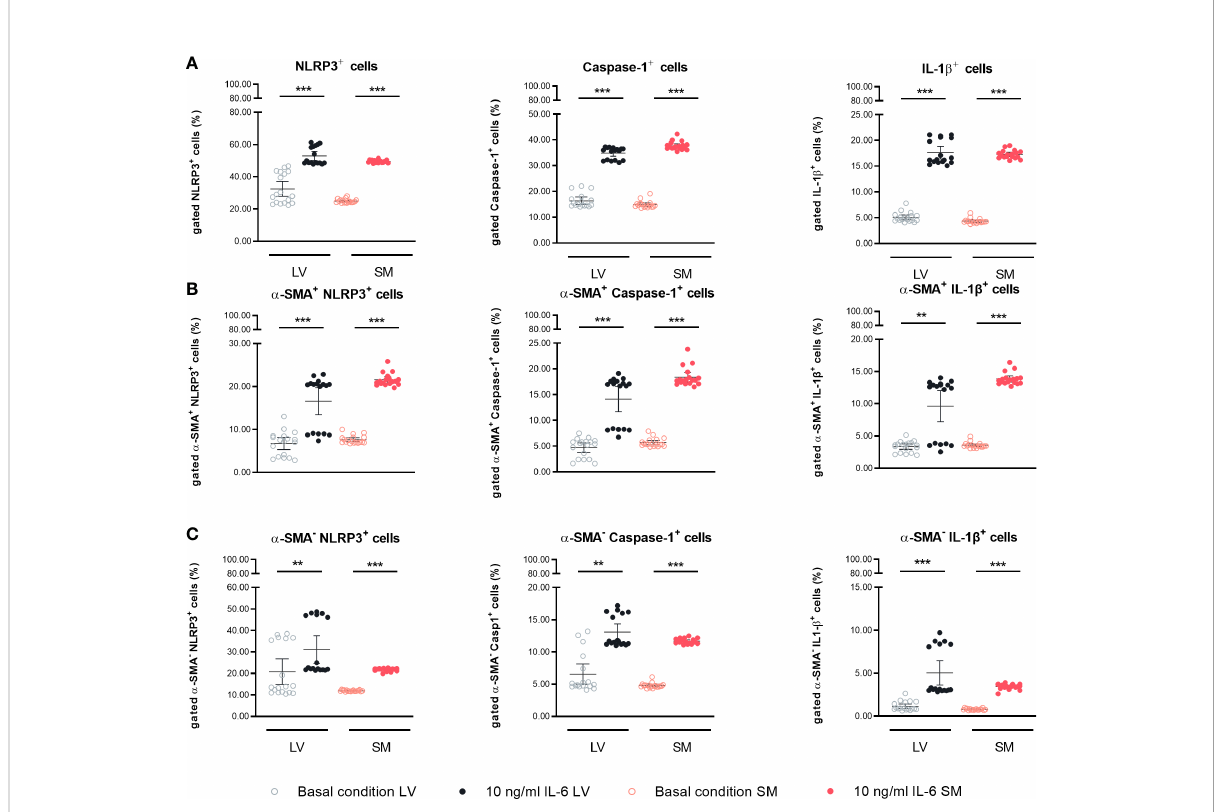
FIGURE 5 IL-6 stimulation leads to upregulation of NLRP3 in fl ammasome activity in left ventricle (LV)- and skeletal muscle (SM)-derived fi broblasts. Percentage of gated (A) NLRP3 + , Caspase-1 + , and IL-1 b + cells in the global population; (B) NLRP3 + , Caspase-1 + , and IL-1 b + cells in the a -SMA + subpopulation; and (C) NLRP3 + , Caspase-1 + , and IL-1 b + cells in the a -SMA − subpopulation of LV-derived (black) and SM-derived (red) fi broblasts after 24-h culture with basal medium without IL-6 (basal condition; bright hollow circle) or with 10 ng/ml of IL-6 (dark fi lled circle), n = 18, N = 3. All data are presented as mean ± 95% CI and tested with post-hoc Benjamini – Hochberg correction; adjusted p-values: **p < 0.01,***p <